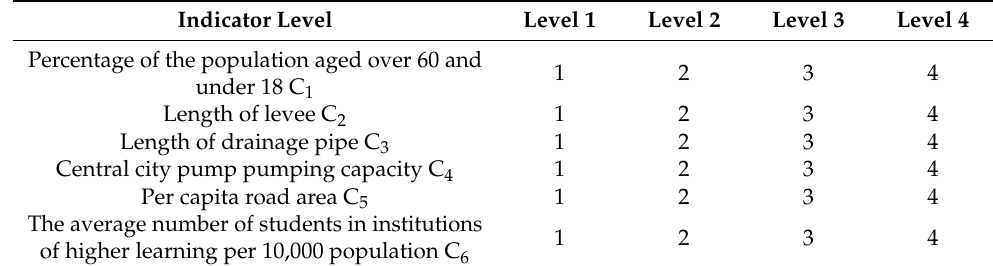
Table 8. Values of resistance evaluation indicator